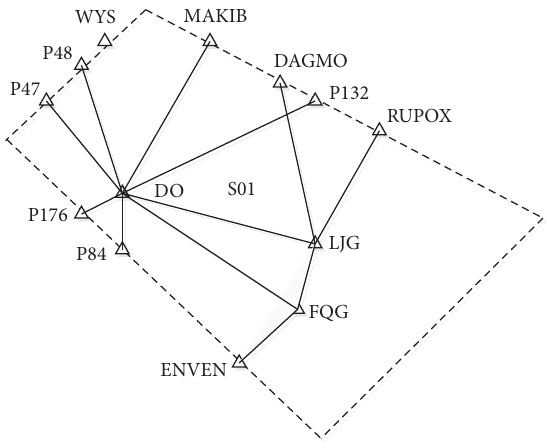
Figure 3: Schematic diagram of the airspace